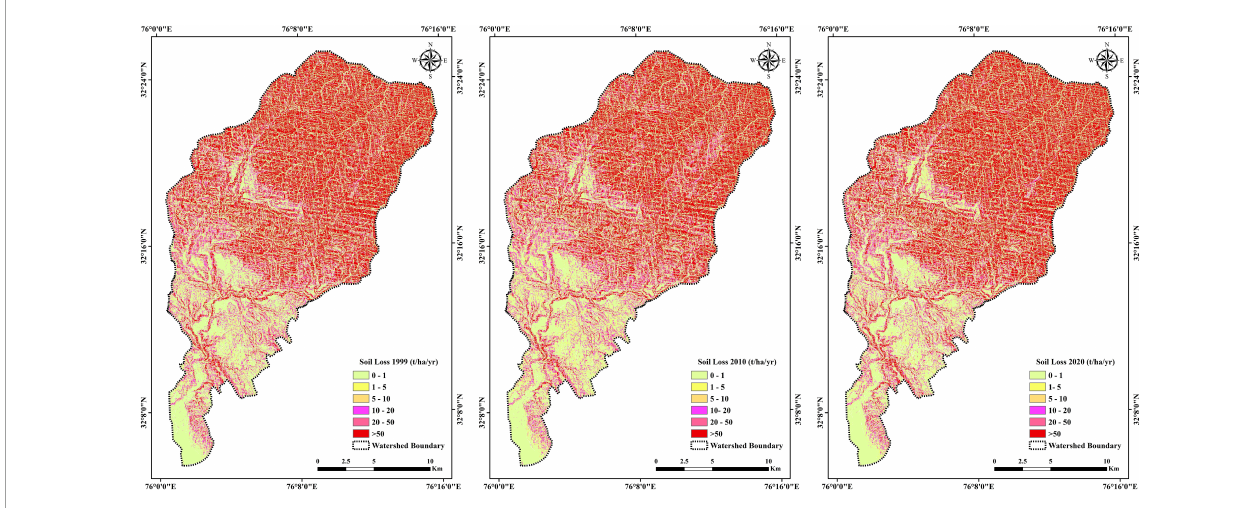
FIGURE14 Maps showing soil erosion trends of the Dehar watershed for the years 1999, 2010, and 2020.